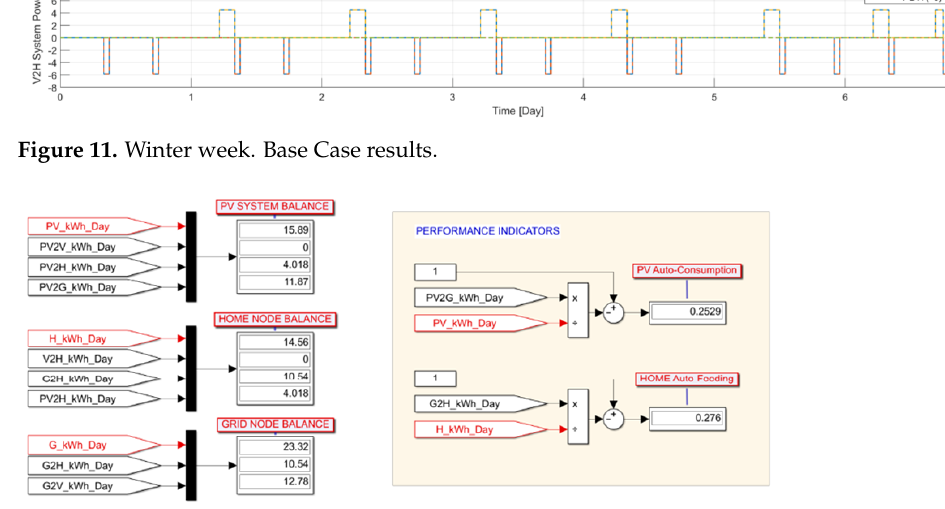
Figure 12. Energy balances at the main nodes ( left ) and performance indicators ( right ) for the Base Case.